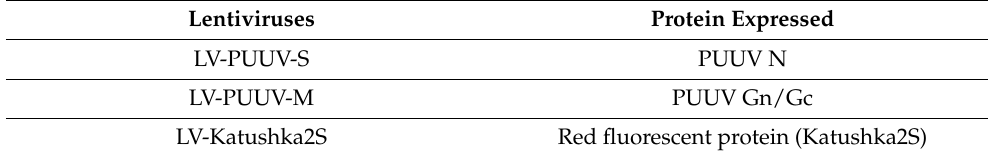
Table 2. Lentiviruses used in this study.